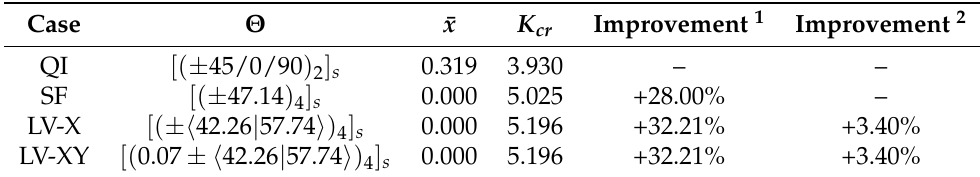
Table 9. Optimal designs and results of the stiffened plate with a central cutout subjected to pure in-plane bending displacements (w/ AFP manufacturing constraints).